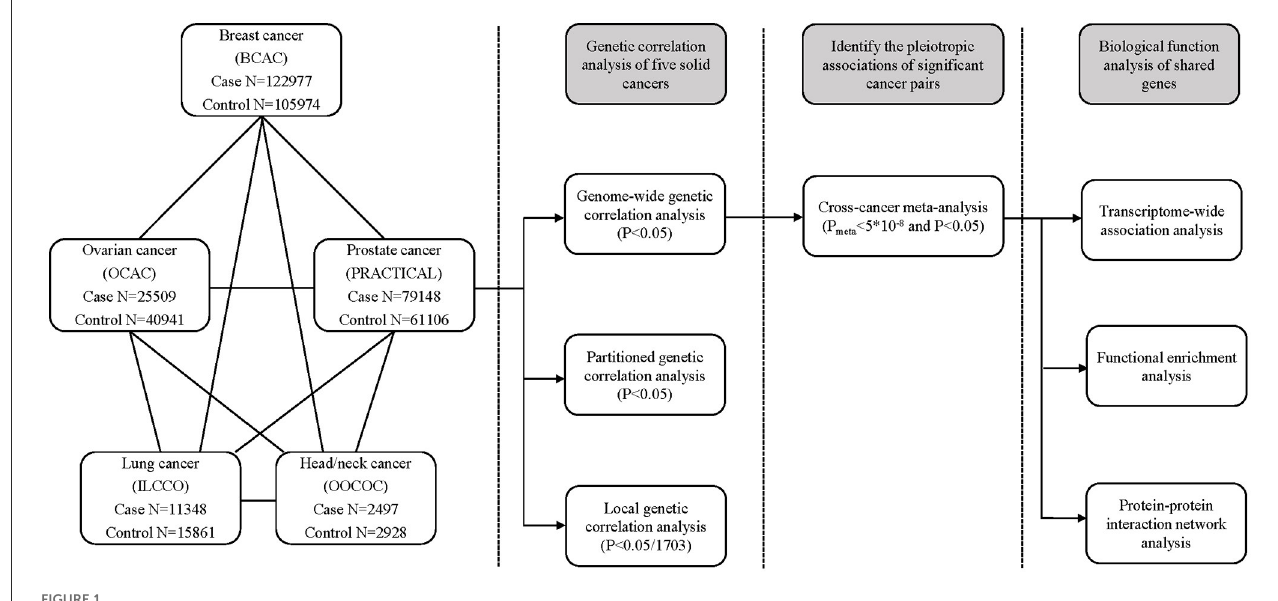
FIGURE1 Schematic overview of the present